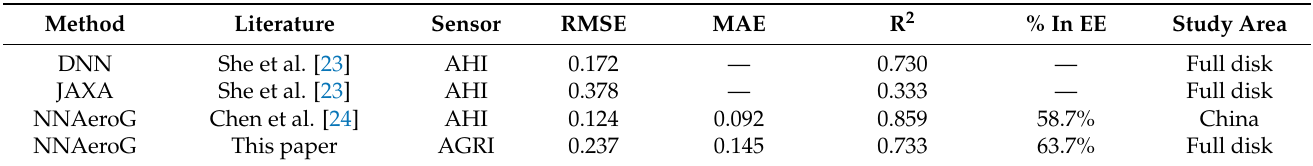
Table 4. Overview of published validation studies of AOD in full disk for different methods applied to multi-spectral sensors and NNAeroG for different multi-spectral sensors.